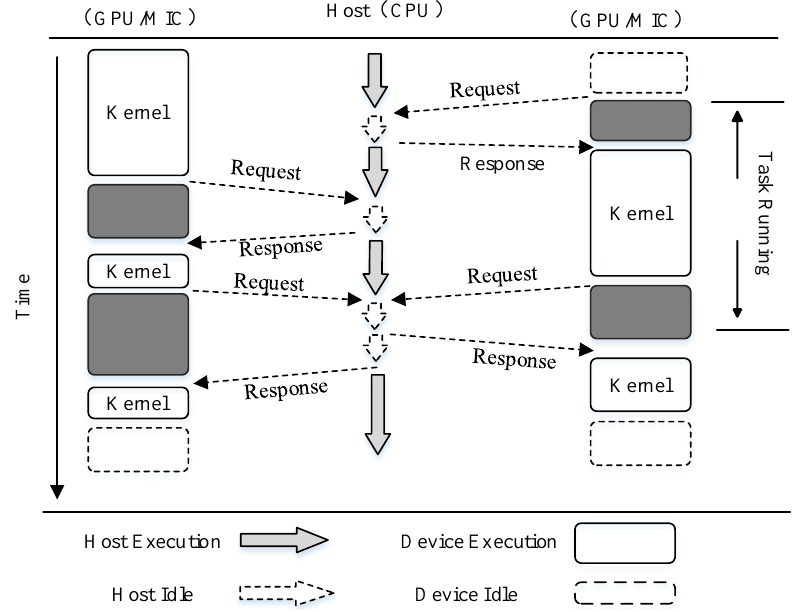
Figure 8. Strategy for load balancing among multiple devices.